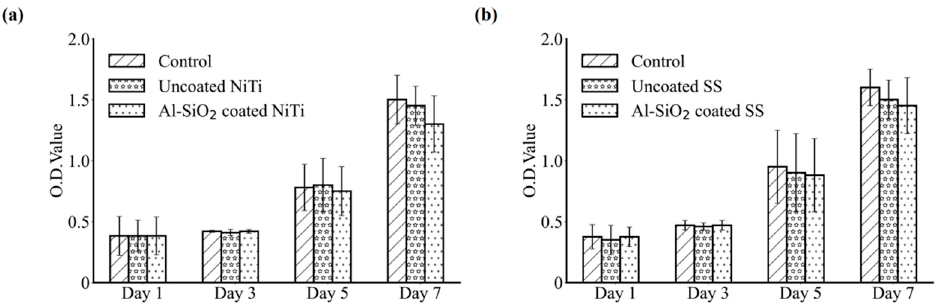
Figure 4. Cytotoxicity test for the coated archwires. Optical density values at different time points in the NiTi group ( a ). Optical density values of mouse fibroblasts at different time points in the SS group ( b ).